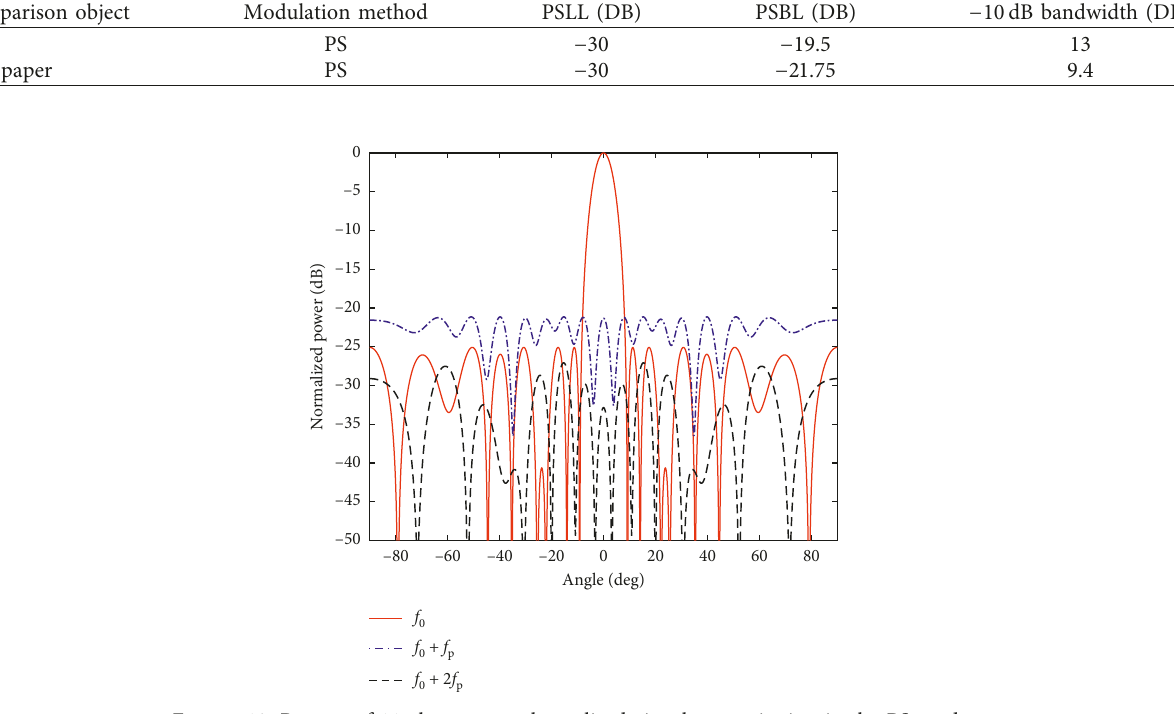
Figure 19: Pattern of 11-element equal-amplitude in-phase excitation in the PS mode. Table 8: Parametric comparison of 16-element between TMSLAs in the PS mode and the results in [20]. Comparison